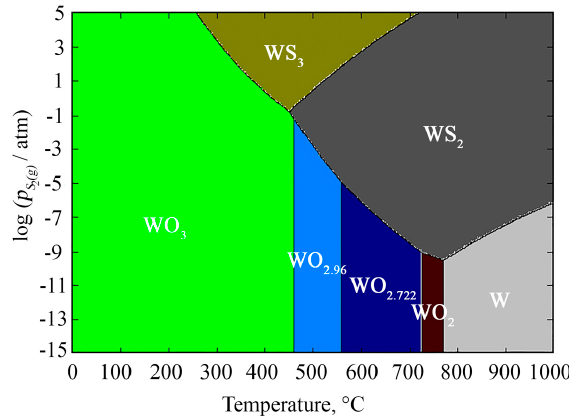
Figure 7. Temperature–partial pressures (Tpp) phase stability diagram for the W–O–S system at constant oxygen partial pressure.